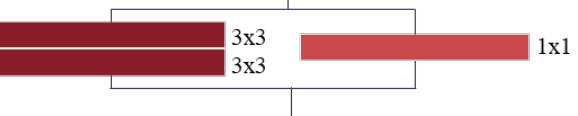
Figure 2 . The Y-residual